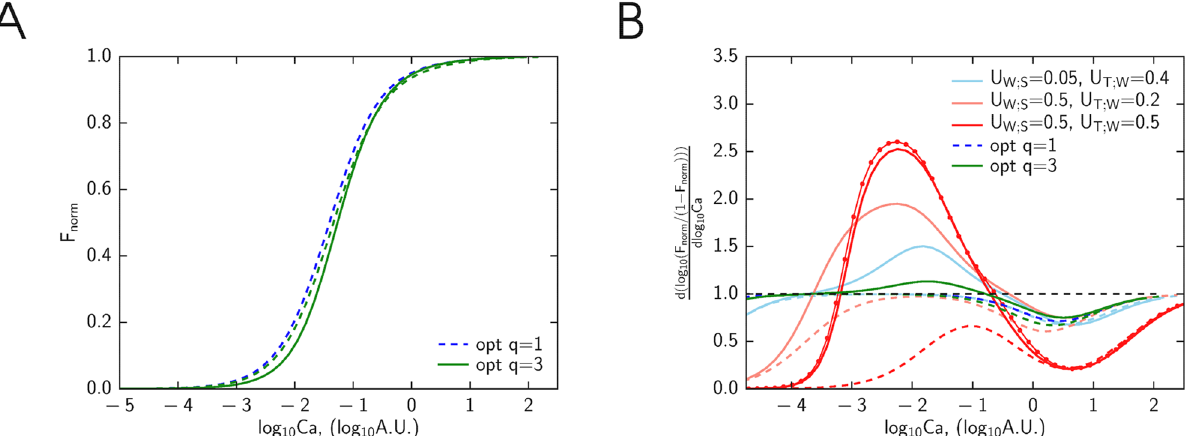
Fig 6. Calcium binding cooperativity measures calculated by the models with the different number of interacting cross-bridges. Here, the steady state solution of models is shown depending on calcium concentration with concentration given in arbitrary units at half-sarcomere length of 1.05 μ m. The model solutions are designated by colors with green and blue depending on whether the parameters were found by fitting the data using q = 3 or q = 1 model, respectively; and by dashed, solid and line with dots, depending on whether the simulations were done using q = 1, q = 3 or q = 4 model, respectively. A: Normalized force-calcium relationship found by the model. All solutions demonstrate the low cooperativity indicating that this aspect of the model has to be refined. B: The Hill coefficient calculated from the slope of force-calcium relationship in log-log scale. For non-cooperative binding, the slope is expected to be 1 (black dashed line). In addition to the solutions found for optimized model parameters, we calculated the Hill coefficient for model solutions with the larger free energy changes induced by tropomyosin deformation (the free energies of the segments are given in the figure legend). Note how the increase in tropomyosin free energy changes induced by cross-bridges and calcium binding leads to the increase of the Hill coefficient in the models with cooperativity effects included ( q = 3 and 4) in contrast to the model with only one cross-bridge that can change its state ( q = 1).